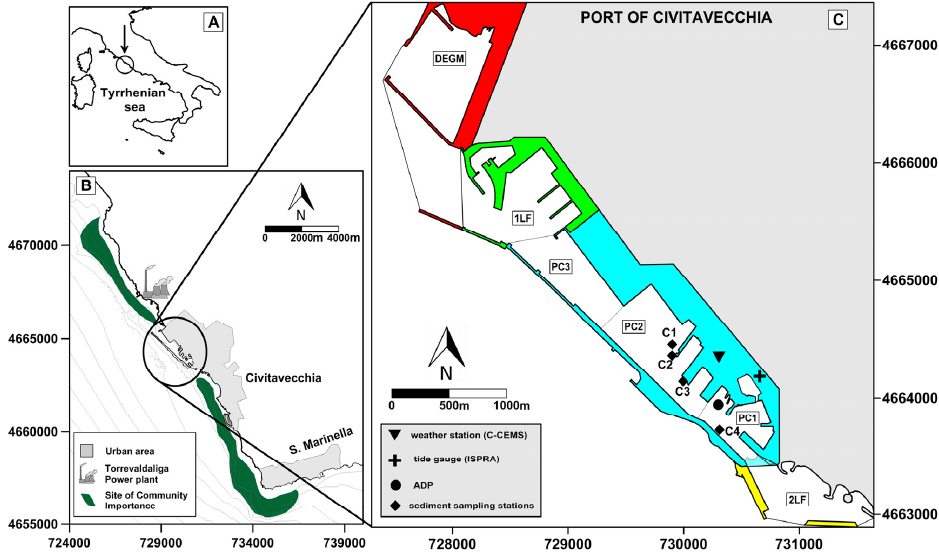
Figure 1. Civitavecchia harbour location along the western Italian coast ( A ). The harbour is located between two SCIs and to the south of the Torrevaldaliga power plant ( B ). Map of the harbour work areas with corresponding sub ‐ basins, sediment sampling stations and the observing system location used in this study ( C